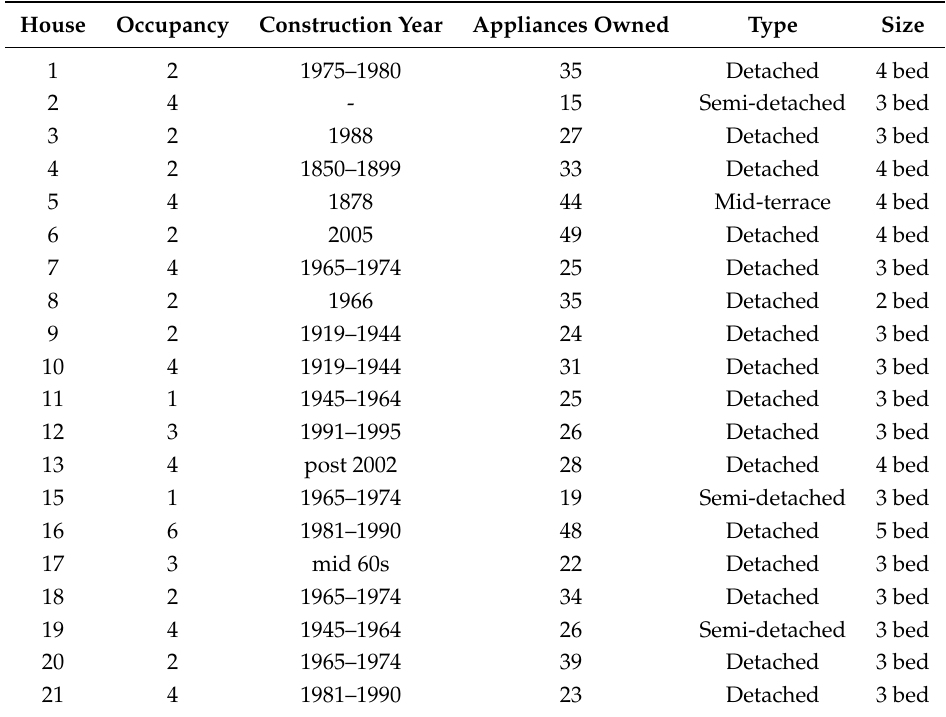
Table A1. Detailed description of the houses including occupancy, construction year, appliances owned, type and size in terms of